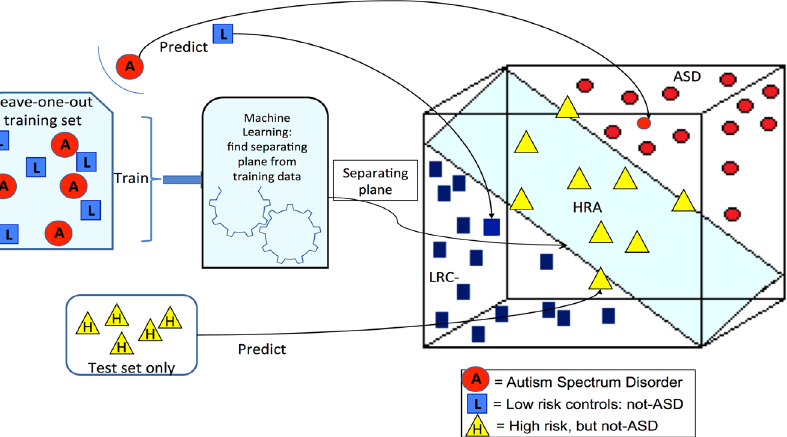
Figure 2. A schematic representation of classification with a support vector machine (SVM) method is shown with 3 dimensions representing 3 features. The training set is used to create a model or separating hyperplane in the feature space. Axes of the feature space are the nonlinear EEG features. Test subjects are then classified by determining which side of the plane the subject’s features places them. ASD and LRC- subjects are used for the training set. Leave-one-out cross validation leaves out a single subject from the training set and then makes a prediction for the left-out subject. The distance of a subject from the hyperplane can be used to estimate severity. This distance was scaled to approximate the Calibrated Severity Score (CSS), where 1.0 is the lowest score for children with no autism symptoms and 10 is the highest score for the most severe autism